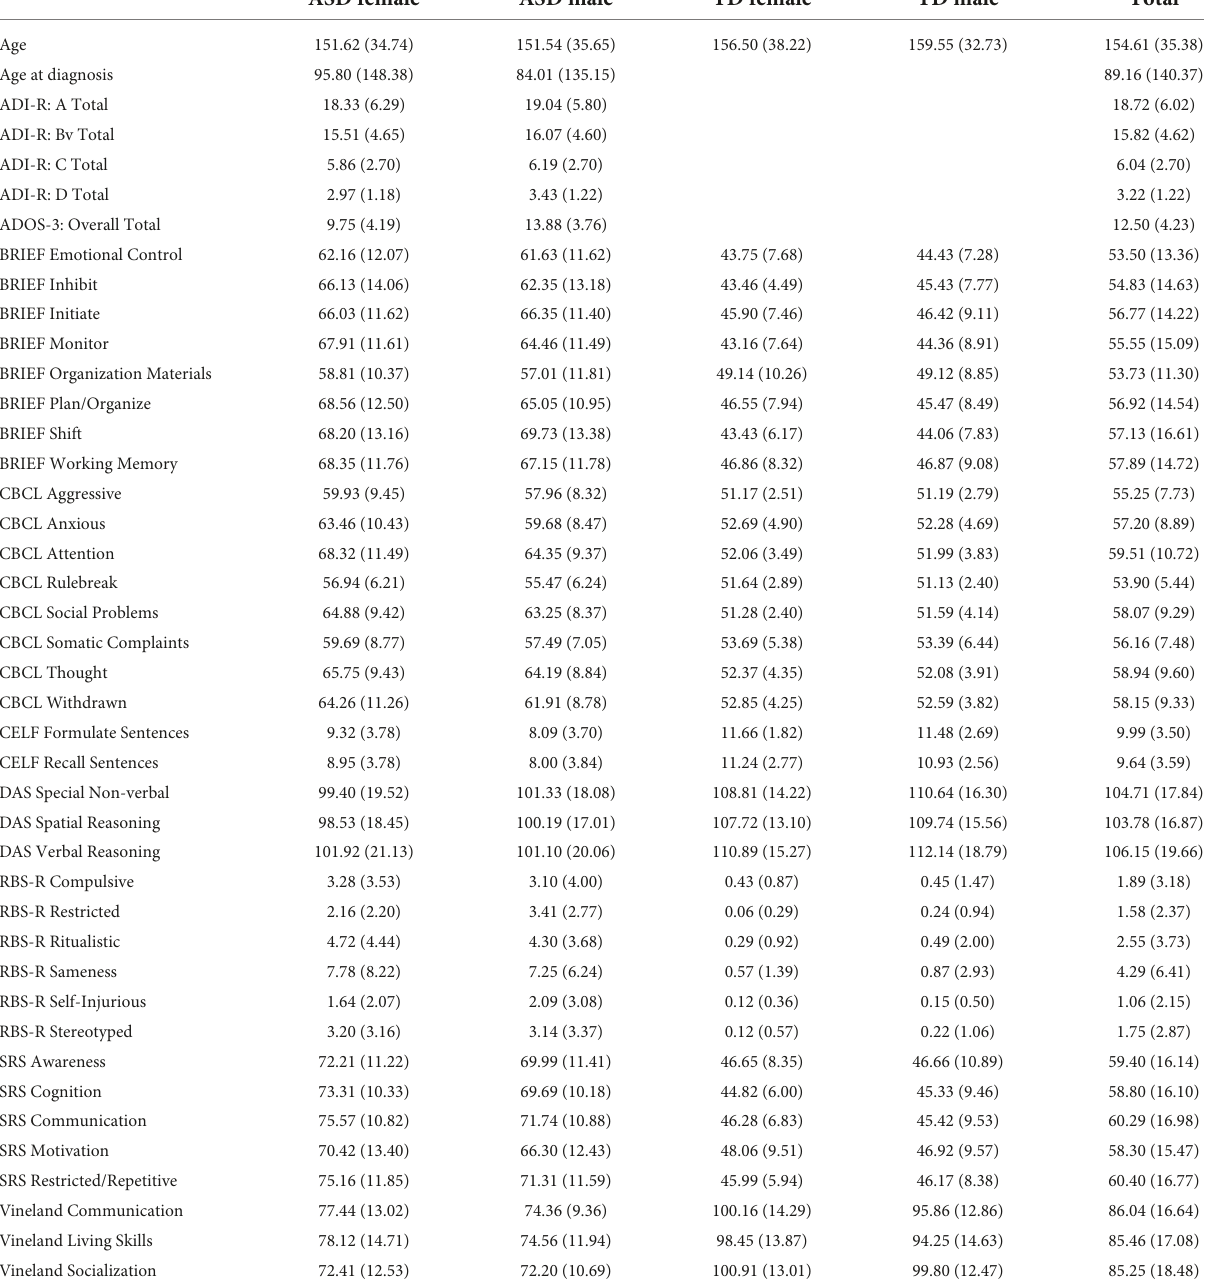
TABLE 1 Demographic and clinical characteristics of the